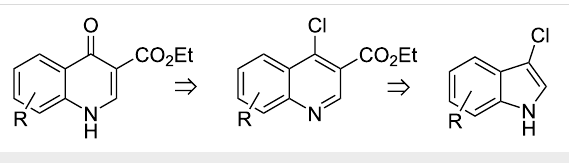
and only traces of C–H or N–H insertion products were ob- served. The yield of ethyl quinoline-3-carboxylate is dependent on the halogen in X-EDA (Cl: 90%, Br: 84%, I: 70%). The reaction works well for substituted indoles with R-groups in po- sitions 3–7. When R at position 8 = Cl, the reaction was slug- gish, and when R at position 2 = Me there was no quinoline formed. The overall transformation is formally a cyclopropan- ation of the indole C2–C3 double bond followed by a spontane- ous ring expansion of the indoline cyclopropane intermediate and elimination of